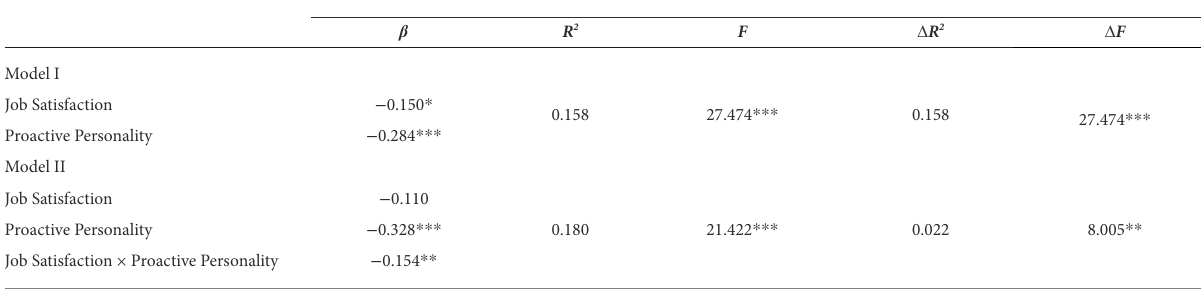
TABLE 7 Hierarchical regression for testing the moderating effect of Proactive Personality (Predicted Variable: Turnover Intention).